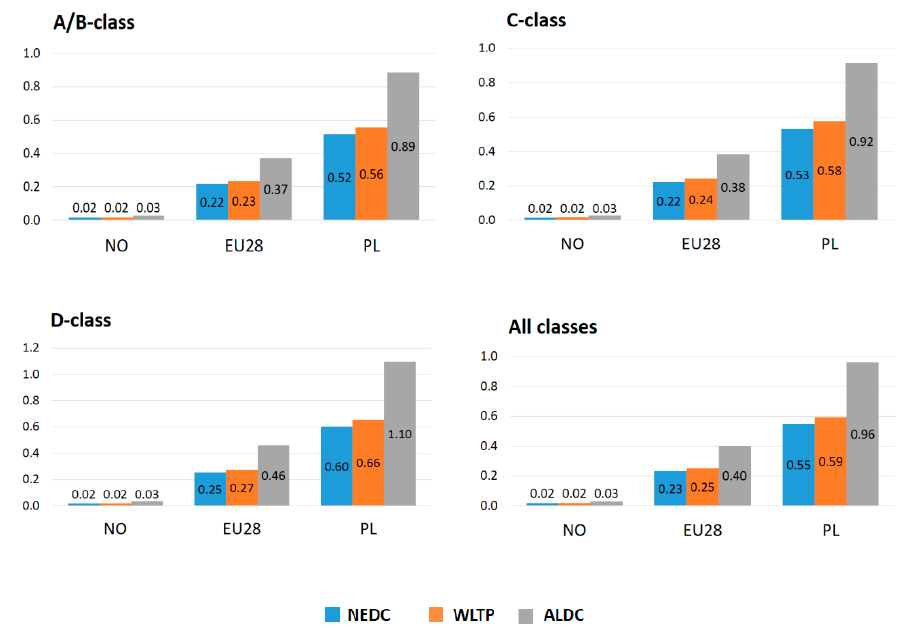
Figure 6. Arithmetic mean of IRV over case studies per vehicle class and driving cycle.